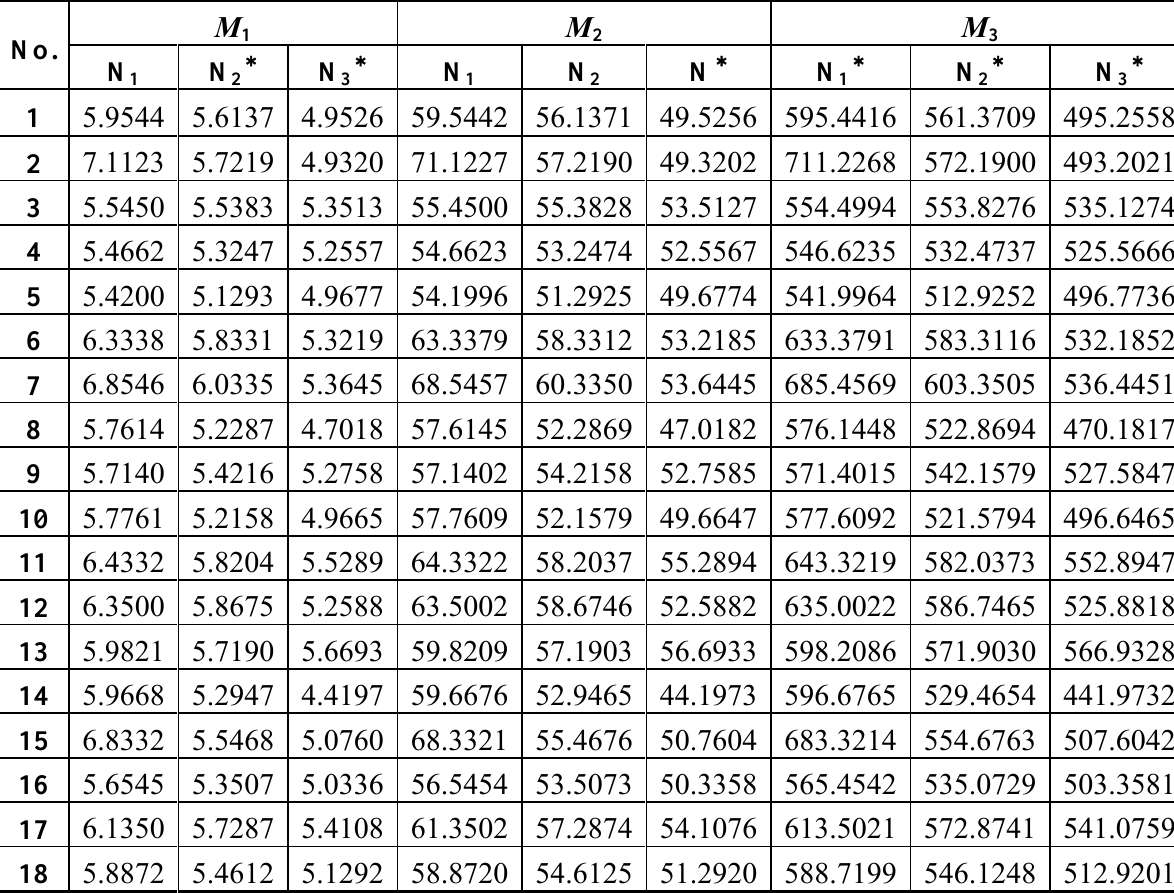
Table 3. Simulation data of dynamic